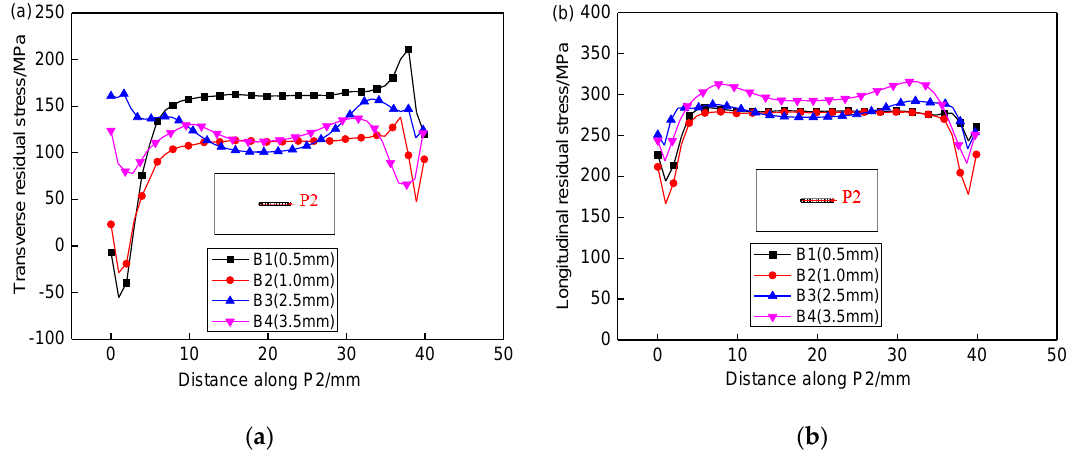
Figure 14. Effect of repair weld reinforcement height on the transverse ( a ) and longitudinal ( b ) residual stresses along P2.